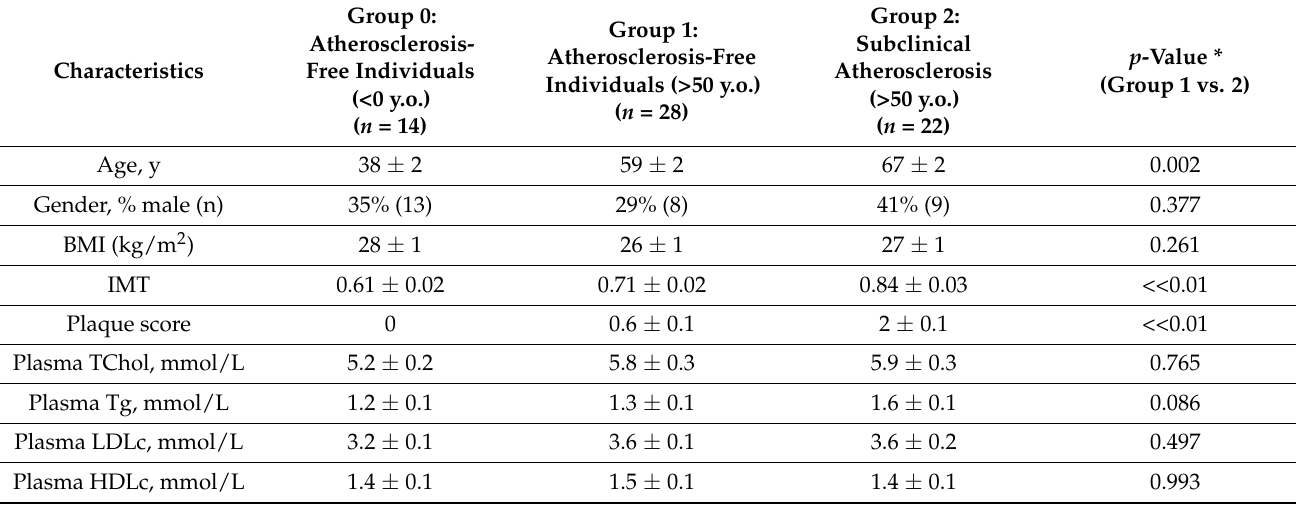
Table 1. Baseline characteristics of the study